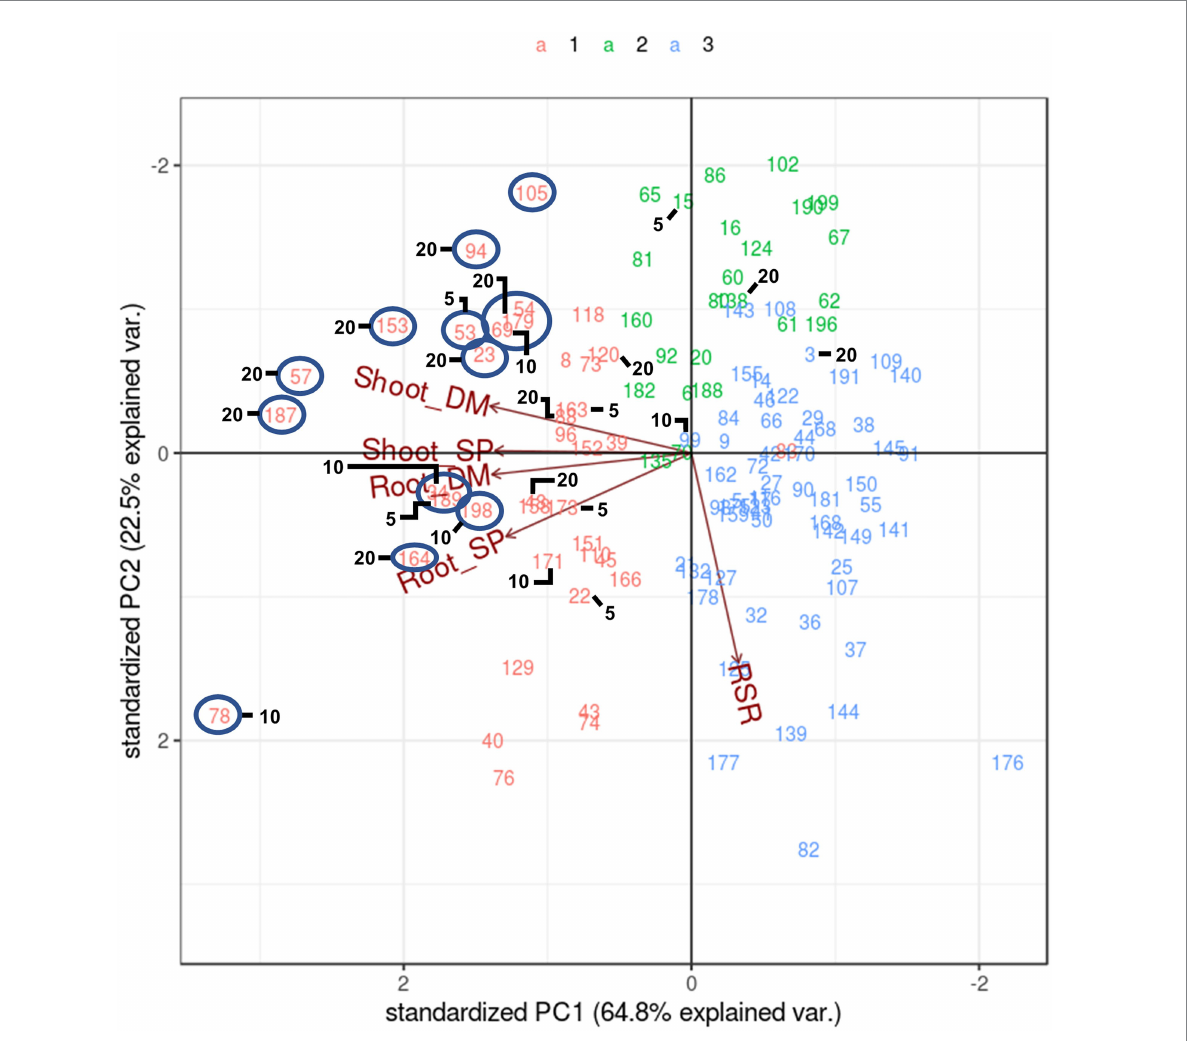
FIGURE 3 Biplot generated by pattern analysis using best linear unbiased predictor (BLUP) adjusted means of 120 white clover half-sib families inoculated with Rhizobium leguminosarum bv. trifolii strain TA1. Plant responses associated with principal component (PCA) dimensions 1 and 2 are Shoot DM (dry matter plant − 1 ); Root DM; Shoot SP (symbiotic potential plant − 1 ); Root SP; RSR (root to shoot ratio plant − 1 ). Numbers and colours (top of figure) indicate half-sib family line number and membership to pattern analysis Cluster groups (1–3), respectively. The circles indicate half-sibling families showing above average expression for traits Shoot DM and SP that may be candidate families for selection. Numbers 5, 10 and 20 denote half-sib families identified using a Smith-Hazel multi-trait selection index based on Shoot DM and SP at 5% (n = 6 families), 10% (n = 12 families) and 20% (n = 24 families) selection pressures, respectively. Combining 5 and 10 yields the 10% selection pressure, whereas 5, 10 and 20 combined are the families at 20% selection